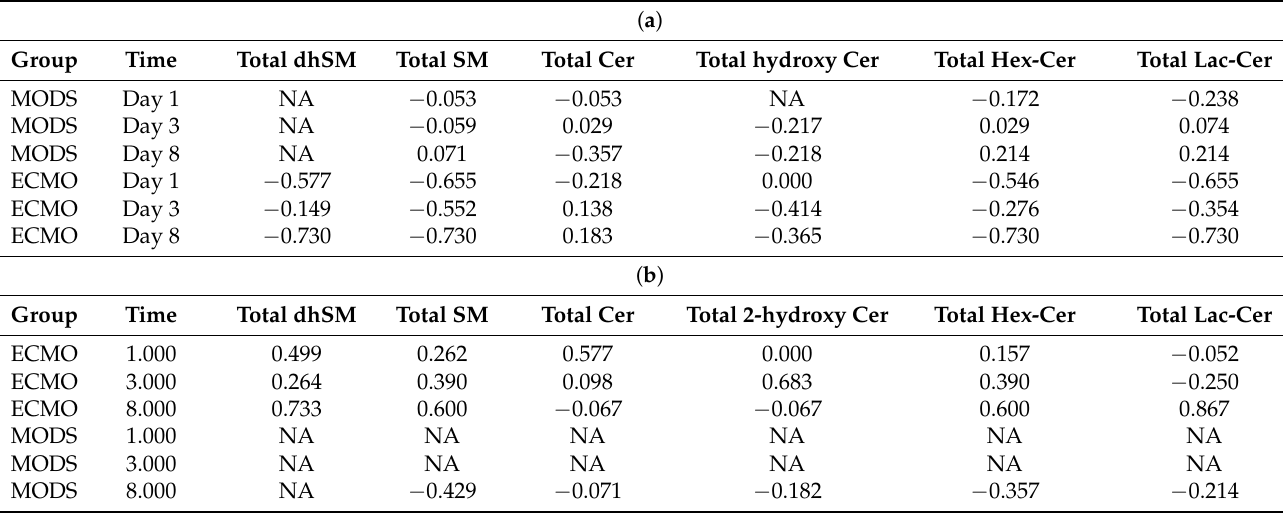
Figure 3. ( a , b ) Time course for percent GPC and SM species lipids over 8 days; ( a ) boxplots; ( b ) geometric mean. Table 3. ( a ) Correlations between lipid values and brain injury (yes/no) in MODS patients over time, ( b ) Kendall correlations between lipid values and percent of total